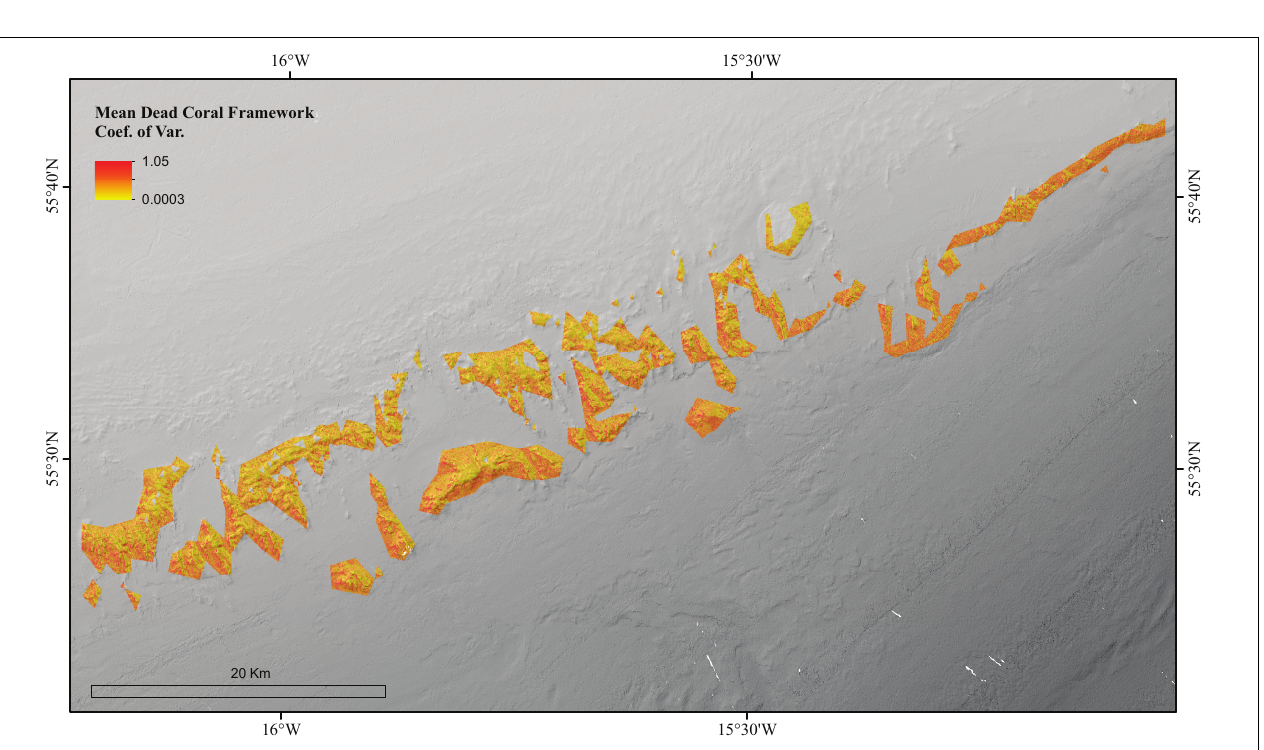
FIGURE 8 | The Coefficient of Variation for the Random Forest model of the mean biomass for dead coral framework in the coral reef habitat area of the Logachev Mound Province.